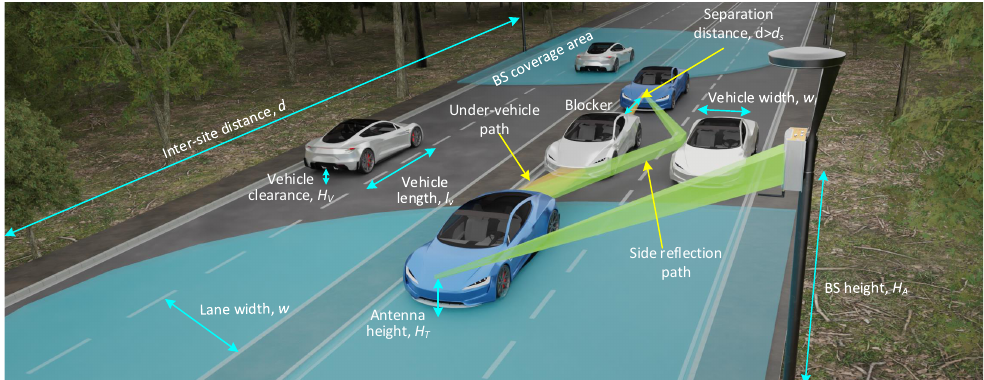
Figure 1. The considered scenario and main components of the system